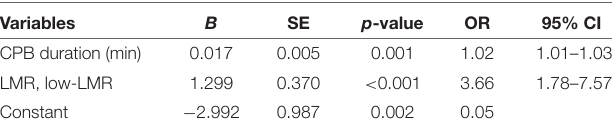
TABLE 5 | Multivariate analysis of risk factors for AKI in ADIAD (second).